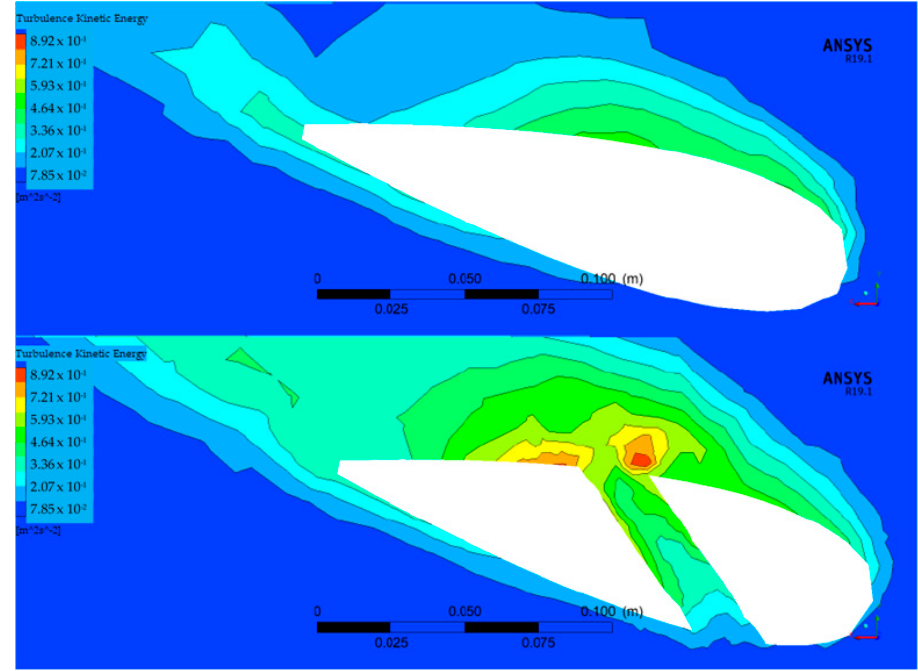
Figure 9. Turbulence kinetic energy in the blade profile section.